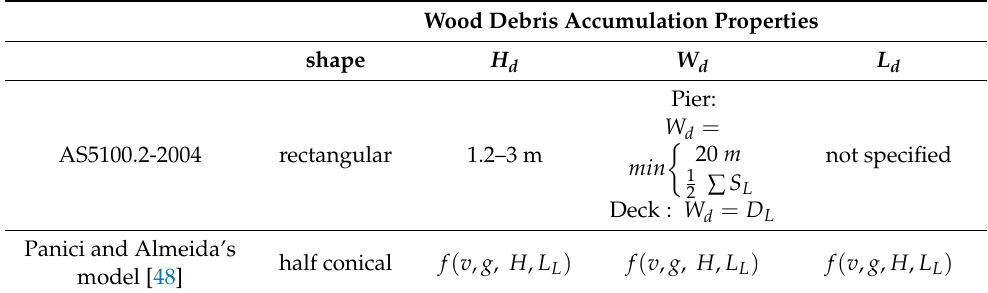
Table 2. Properties assigned to wood debris accumulation according to the two modelling